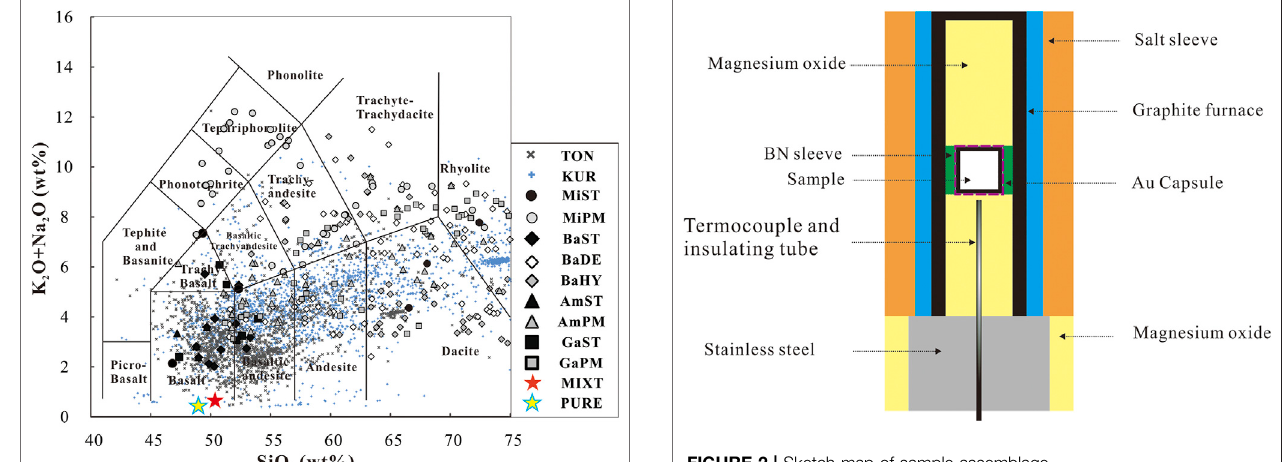
FIGURE 2 | Sketch map of sample